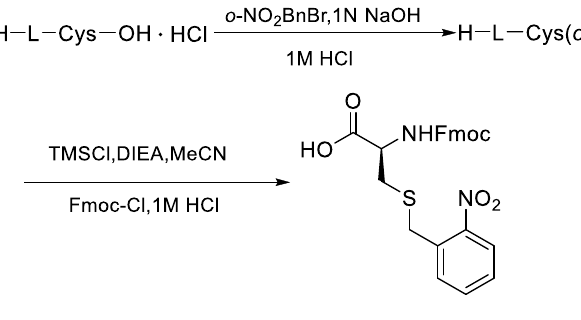
Figure 4. Synthesis of Fmoc- L -Cys(S-o-NBn)-OH. Table 1. Optimizing reaction conditions for formation of the third disulfide bond from UV light reaction.